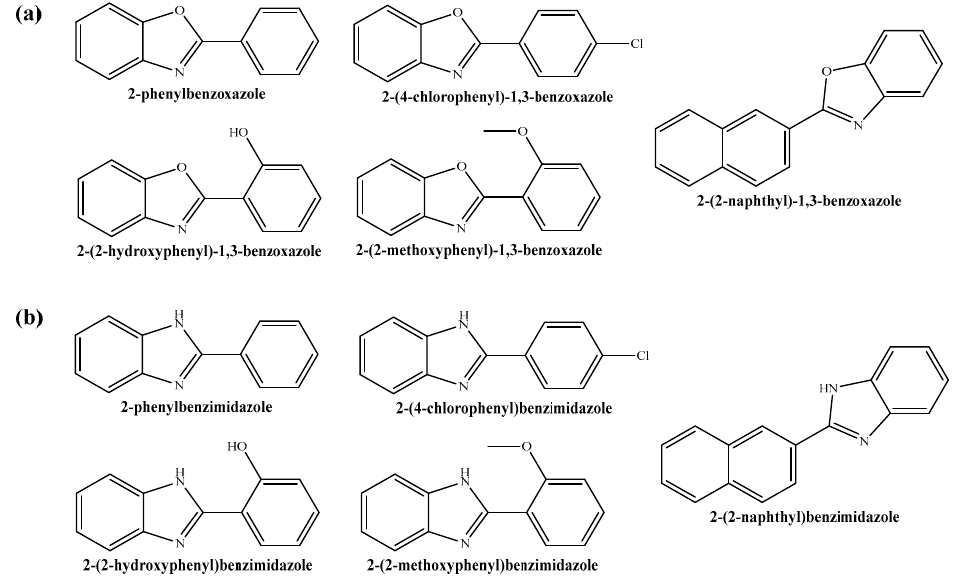
Figure 6. Synthesized products: ( a ) benzoxazoles and ( b ) benzimidazoles. Detailed conditions of the photocatalytic synthesis of the benzoxazoles and Detailed conditions of the photocatalytic synthesis of the benzoxazoles and benzimi- dazoles are summarized in Tables 3 and 4,